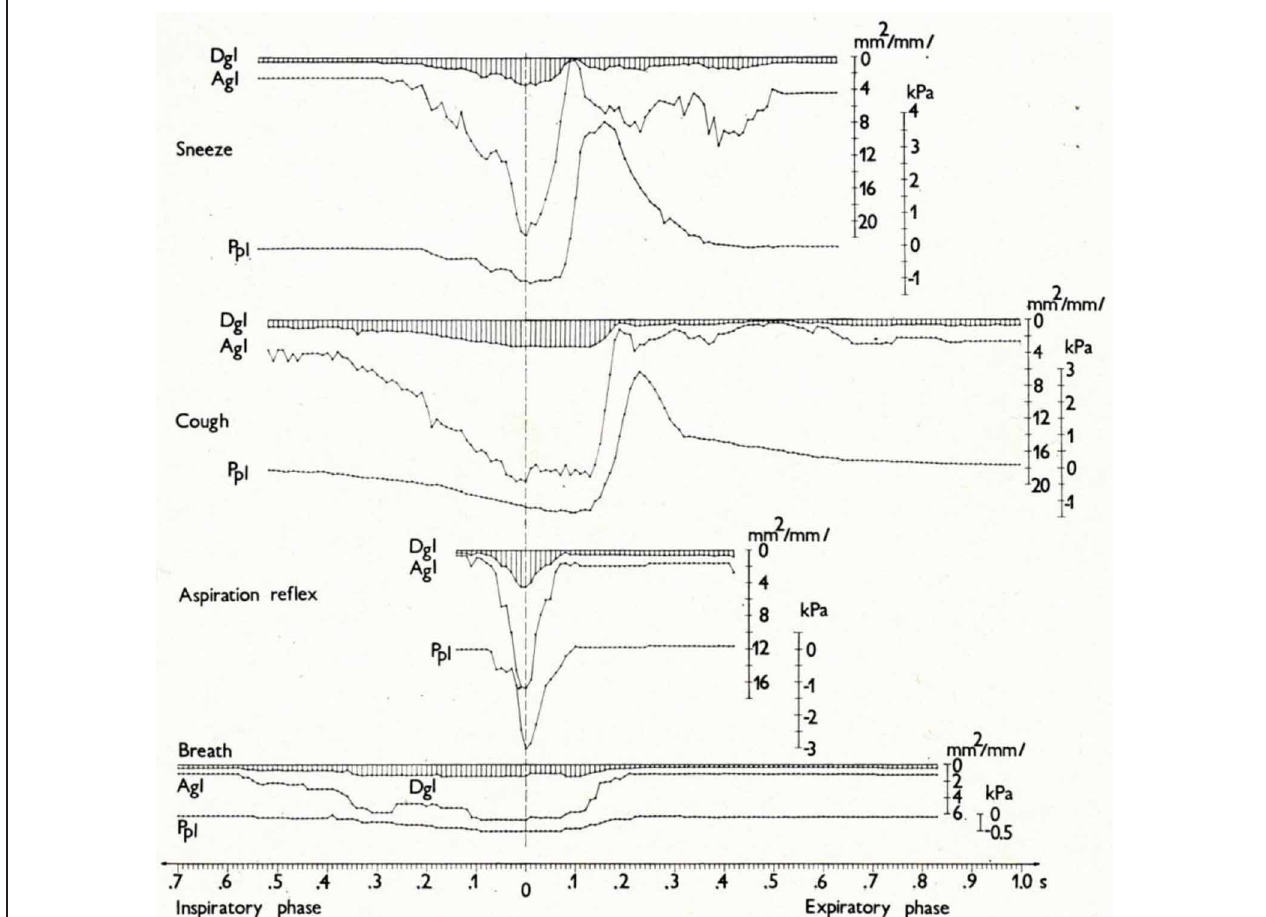
FIGURE 5 | Changes in glottal diameter and area, and pleural pressure in the sneeze, cough, AspR, and control breath in cats. Dynamics of synchronous changes in glottal diameter (Dgl) and area (Agl) as well as in instantaneous pleural pressure (Ppl) during one inspiratory-expiratory cycle of the sneeze, cough, aspiration reflex, and control breath. Mean values for anesthetized cats are indicated